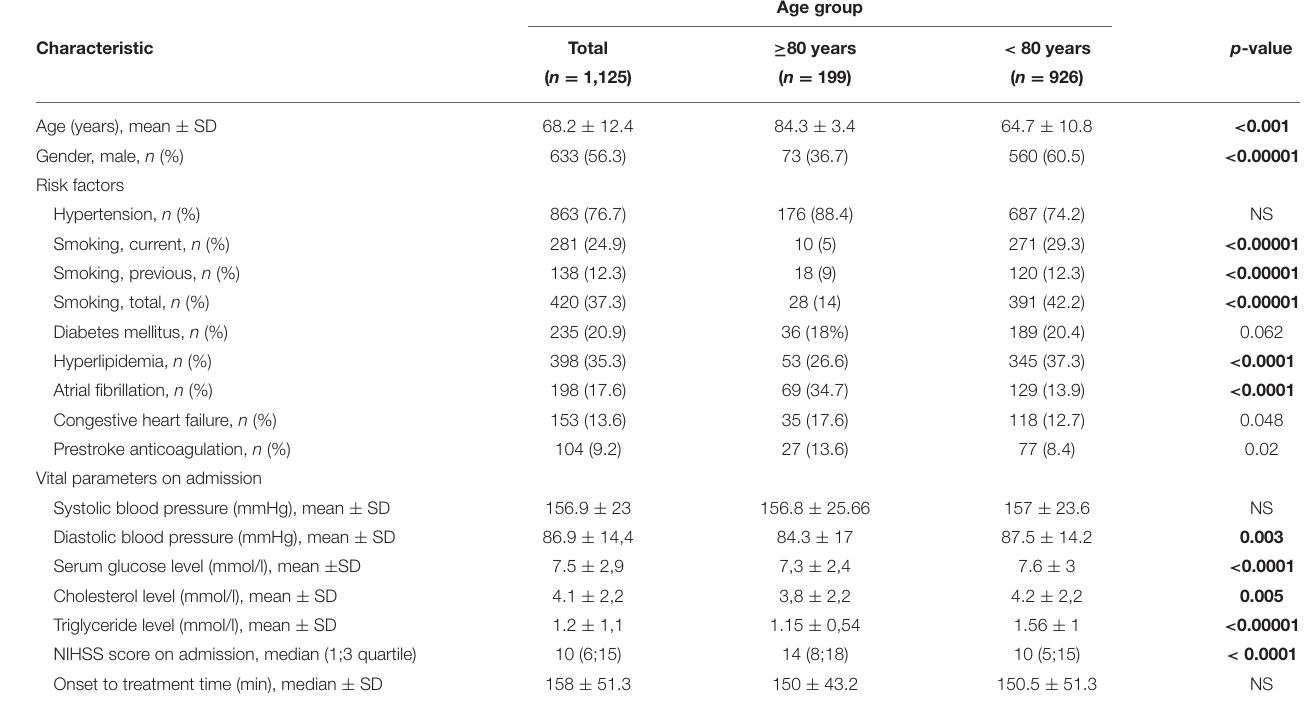
TABLE 1 | Baseline patient characteristics.